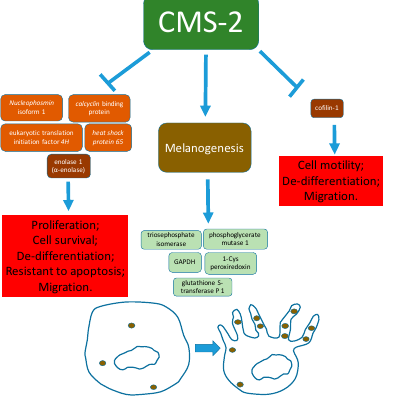
Figure 8. Summary of the molecular and cellular effects observed in melanoma B16 ‐ F10 after treatment with CMS ‐ 2 fraction from Vasconcellea cundinamarcensis .